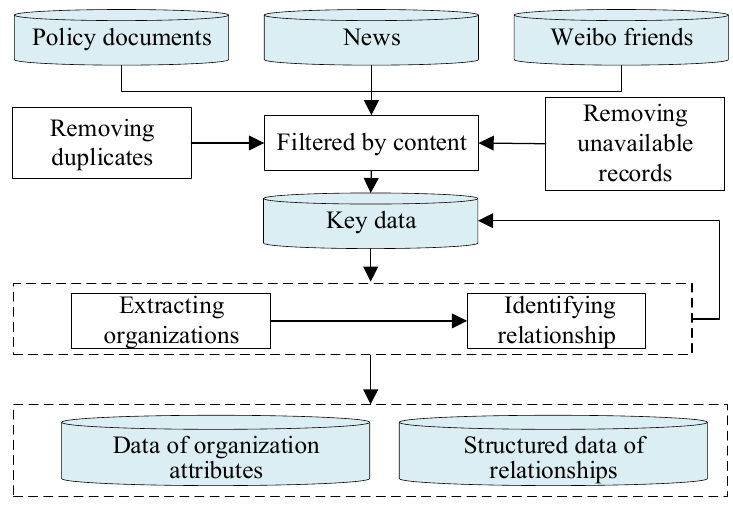
Figure 2. Data processing procedure.